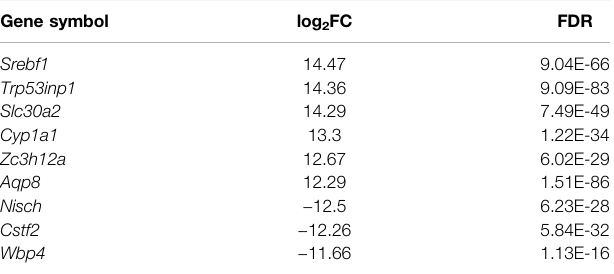
TABLE 1 | Notable differentially expressed coding genes responsive to mechanical stress. Gene symbol log 2 FC FDR